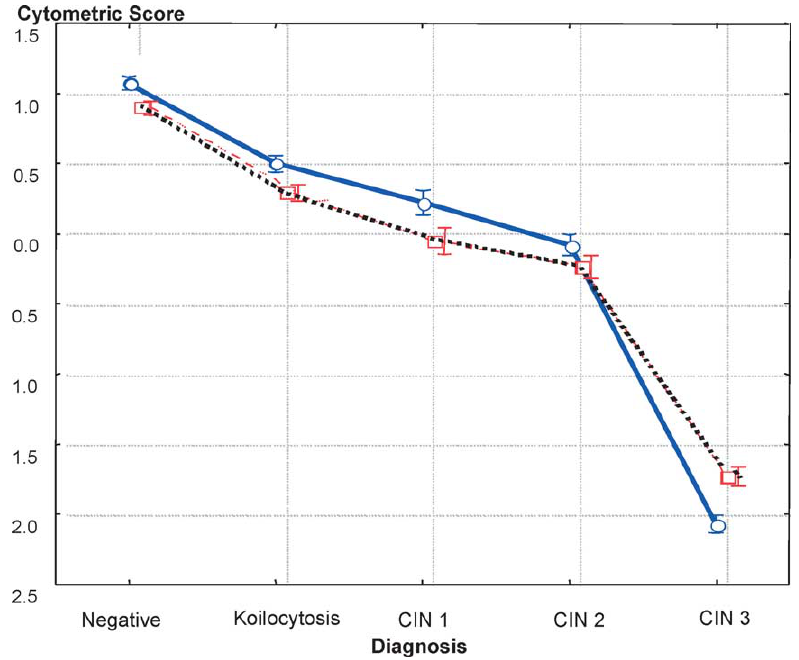
Fig. 2. Correlation between the morphometric scores and the pathology diagnosis. – ◦ –: Normalisation by the mean DNA amount of epithelial cells. --- (cid:1) ---: Normalisation by the mode of the DNA amount of the lymphocytes.